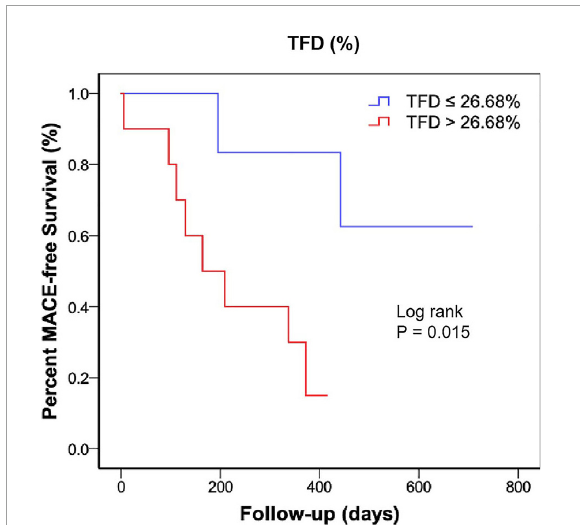
FIGURE4 Kaplan-Meier curve showing MACE-free survival rate according to the TFD in patients with CS. MACE, major adverse cardiac events; TFD, total FDG uptake deficit; CS, cardiogenic